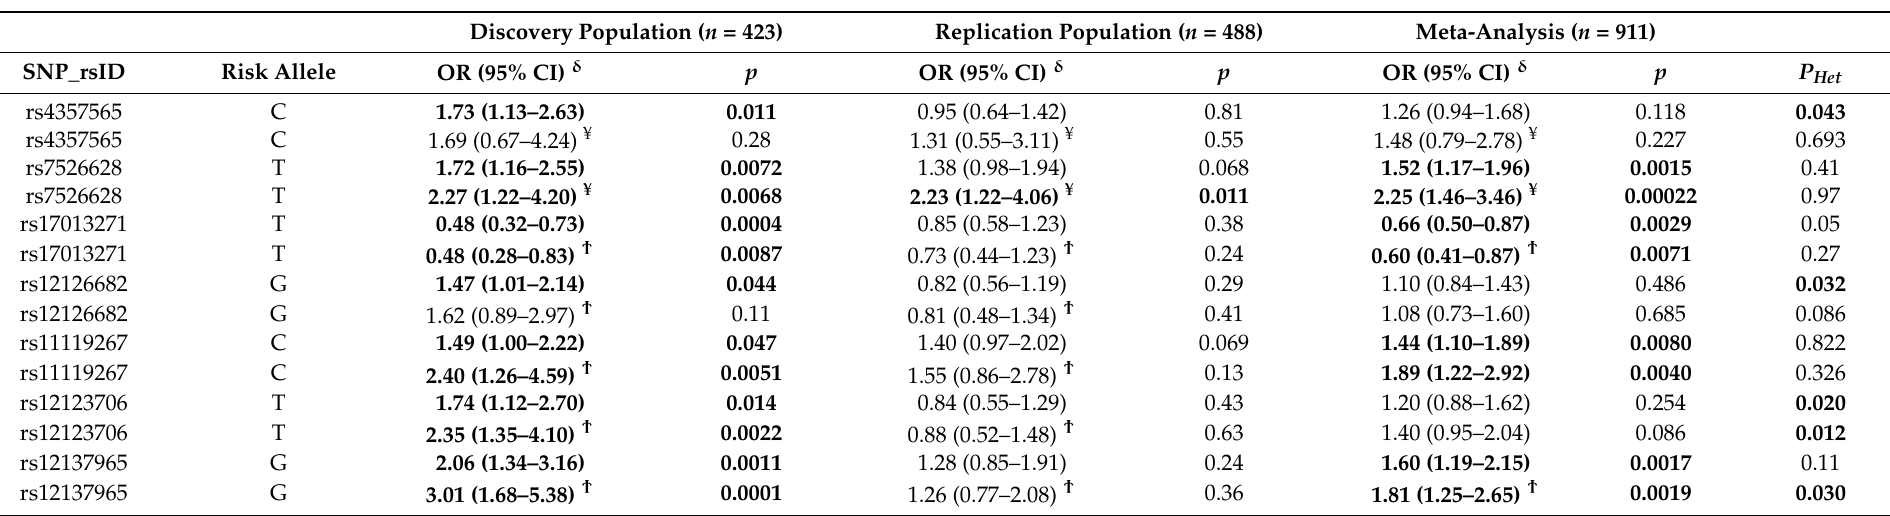
Table 3. Association analysis of the most significant SNPs within TNFSF4 and MAPKAPK2 regions in the meta-analysis of study cohorts.